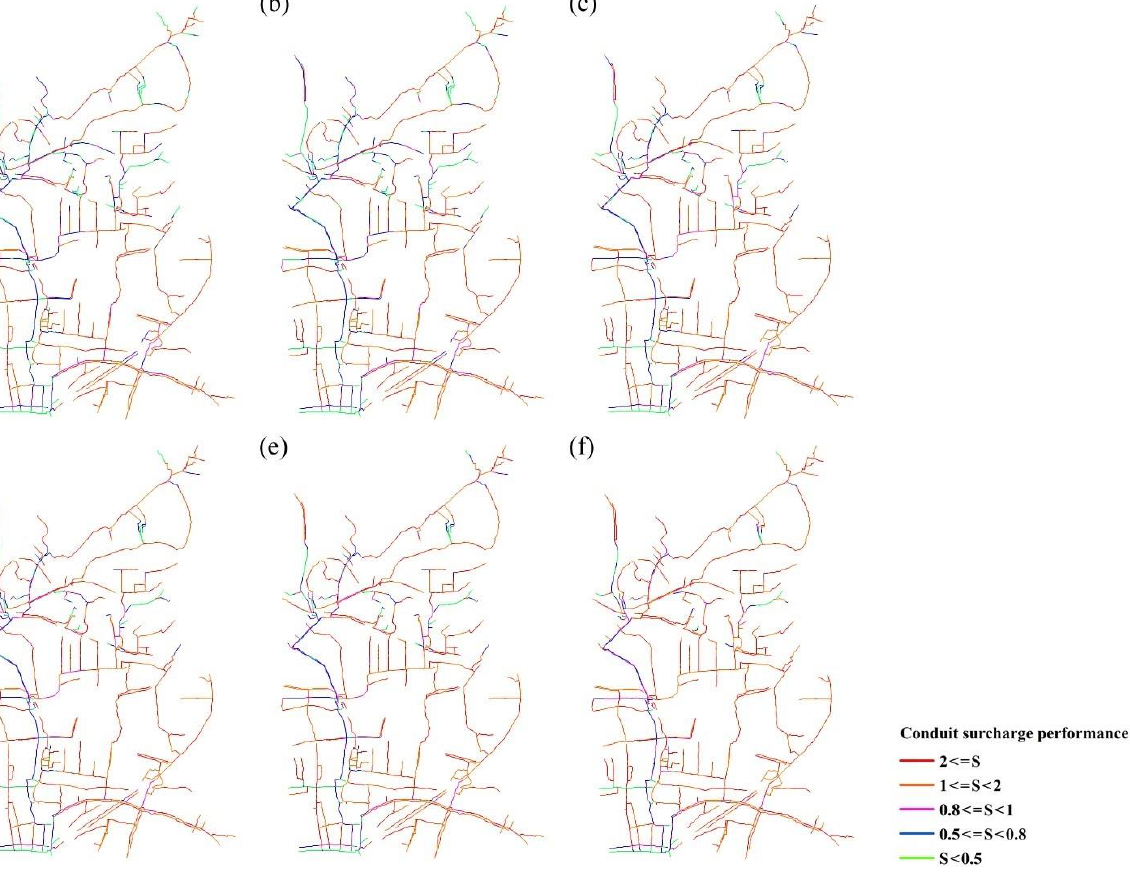
Figure 6. The spatial distribution of conduit surcharge performance. ( a ) 2a return period under RF period. ( b ) 2a return period under RCP4.5. ( c ) 2a return period under RCP8.5. ( d ) 20a return period under RF period. ( e ) 20a return period under RCP4.5. ( f ) 20a return period under RCP8.5. Table 11. Conduit surcharge performance RCP4.5 relative RF (unit: %). RCP4.5-RF